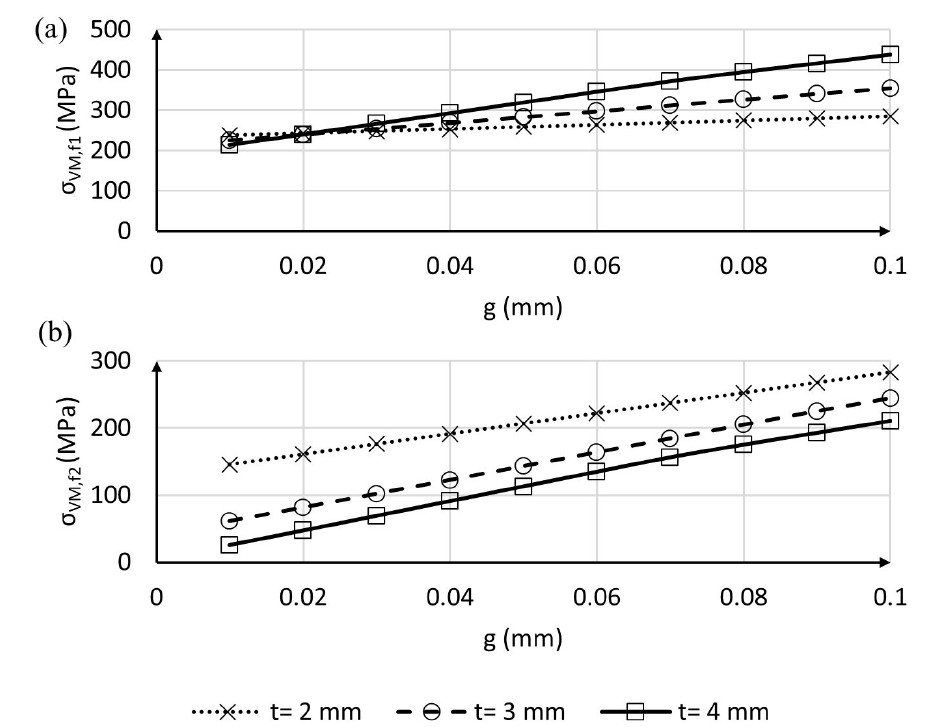
Figure 7. Peak stresses on ( a ) fillet 1 and ( b ) fillet 2 for different thicknesses of the membrane (p = 6